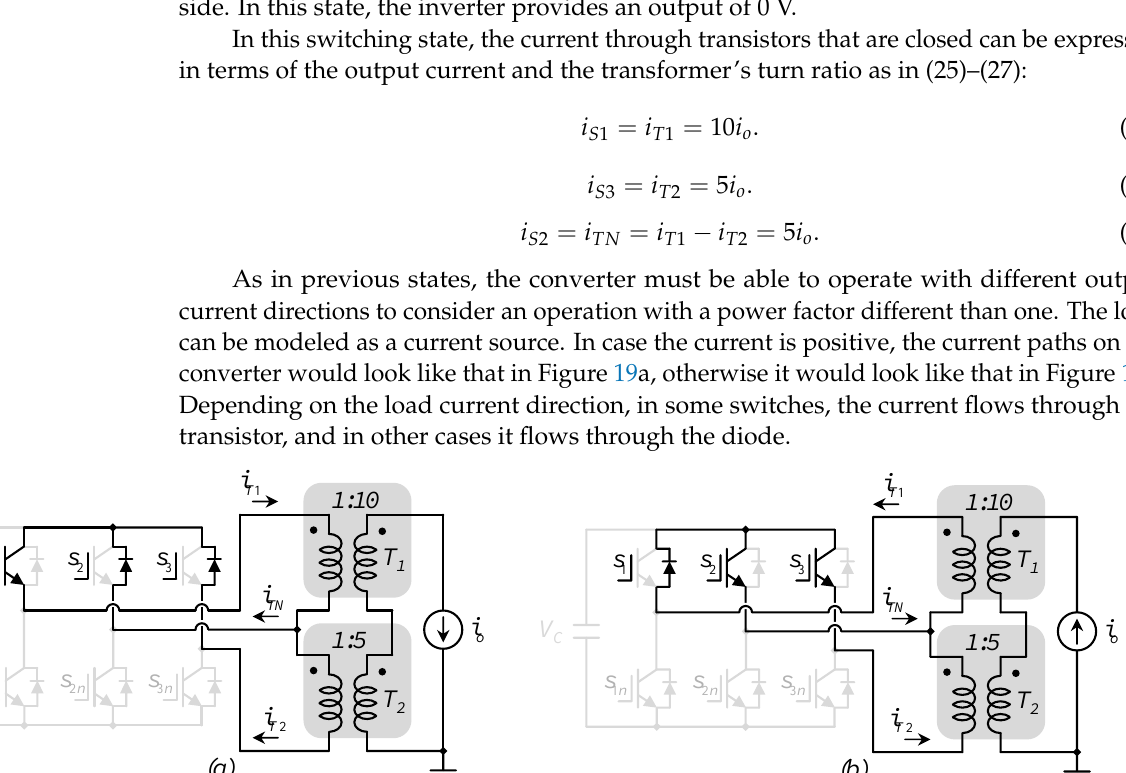
Figure 18. Equivalent circuit when s 1 = 1, s 2 = 1, and s 3 = 1 ( s 1 n = 0, s 2 n = 0, and s 3 n = 0).